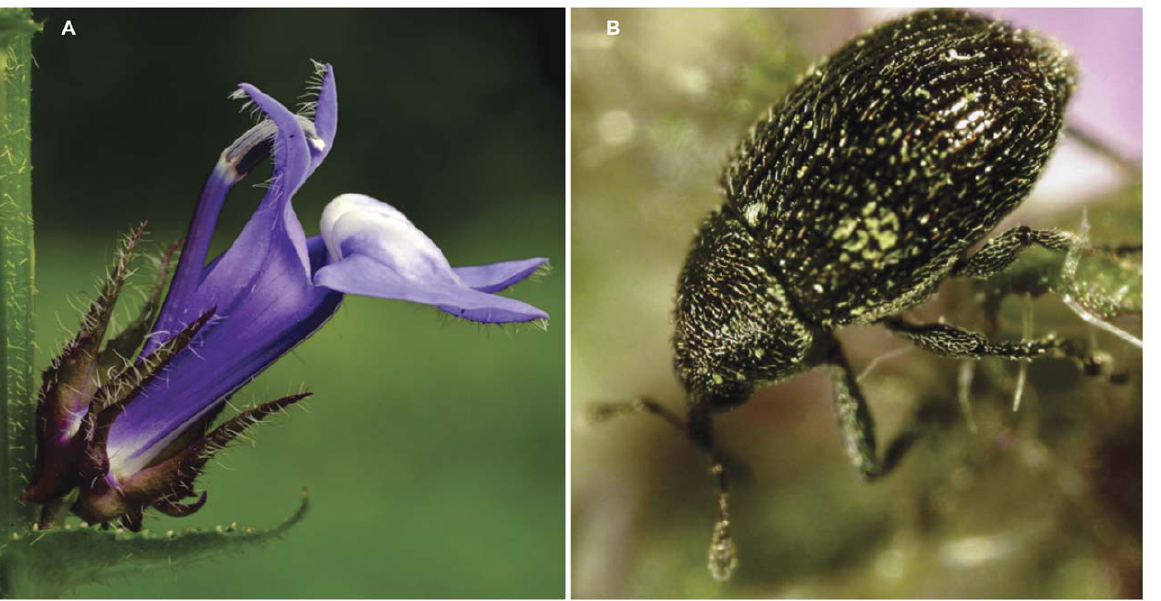
Figure 1. Lobeliasiphilitica flower (A) and its specialist pre-dispersal seed herbivore, Cleopmiarushispidulus (B). Photo credits: flower by Brian Husband, seed herbivore by Amy Parachnowitsch.